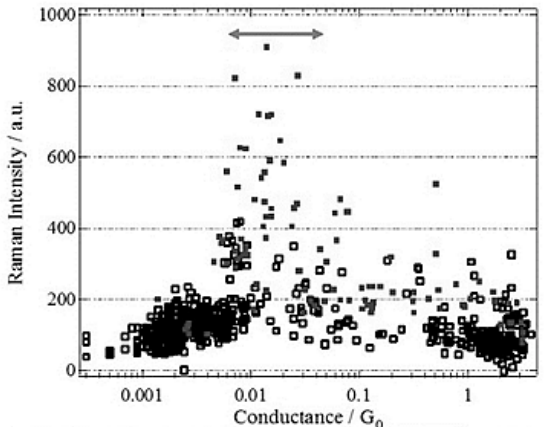
Figure 5. SERS intensity as a function of the conductance of the BPY molecular junction. The arrow indicates the conductance regime of BPY single-molecular junction [37]. The hollow and solid squares correspond to the molecular junctions showing the totally symmetric a mode and the non-totally symmetric b mode in SERS, respectively.